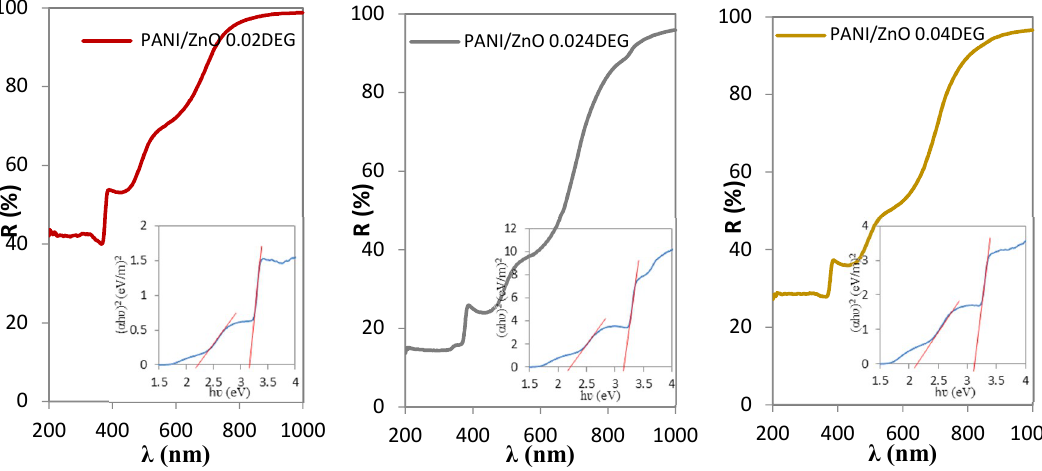
Figure 5. Ultraviolet (UV)-Vis reflectance spectra of the prepared PANI/ZnO composites. The insert shows the plot of ( α h υ ) 2 versus photon ( h υ ).